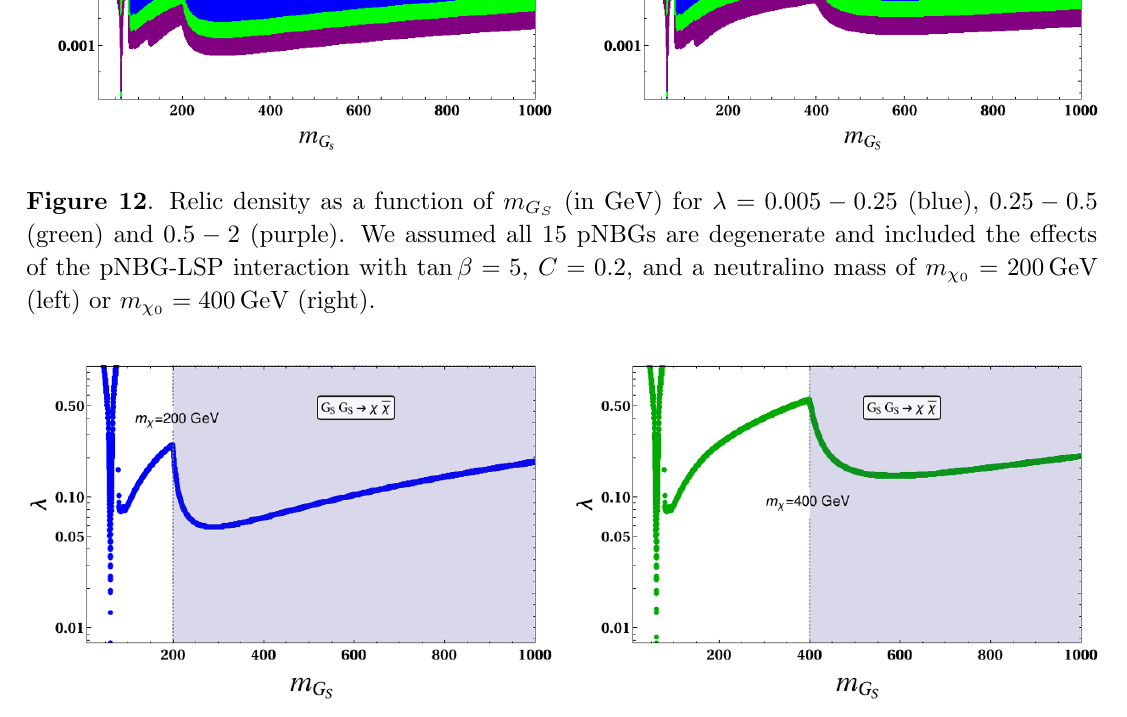
Figure 13 . Region in the (cid:21) (cid:0) m G assumed all 15 pNBGs are degenerate and included the e(cid:11)ects of the pNBG-LSP interaction with tan (cid:12) = 5, C = 0 : 2, and neutralino mass of m (cid:31)